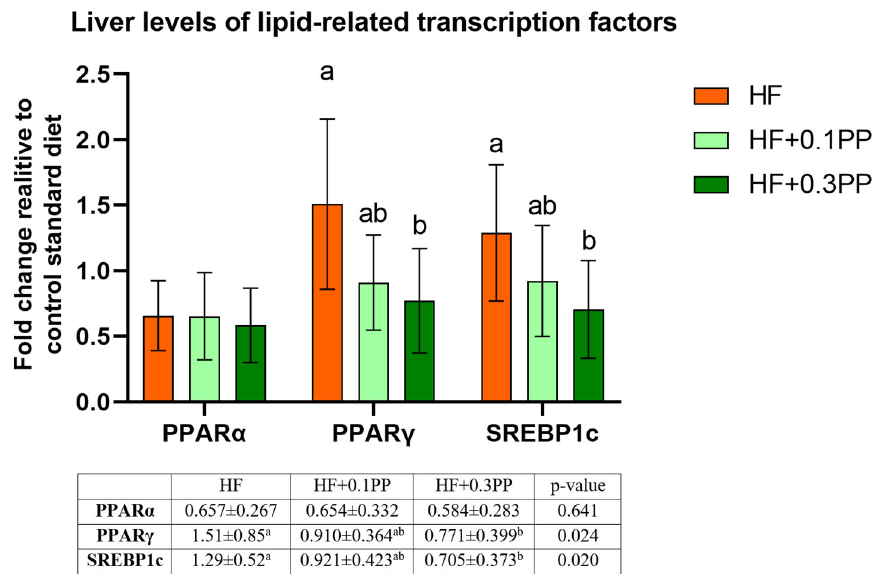
Figure 2. mRNA expression of PPAR α , PPAR γ , and SREBP-1c in the livers of rats fed experimental diets (expressed as fold change relative to the control). The values are the means ± SEMs. HF, group fed a high-fat diet; HF + 0.1PP, group fed a high-fat diet supplemented with 0.1% raspberry polyphenolic extract; HF + 0.3PP, group fed a high-fat diet supplemented with 0.3% raspberry polyphenolic extract. Mean values with different superscript letters (a or b) are different at p < 0.05 (post hoc test). PPAR α , peroxisome proliferator-activated receptor alpha; PPAR γ , peroxisome proliferator-activated receptor gamma; SREBP-1c, sterol regulatory element-binding protein 1c.